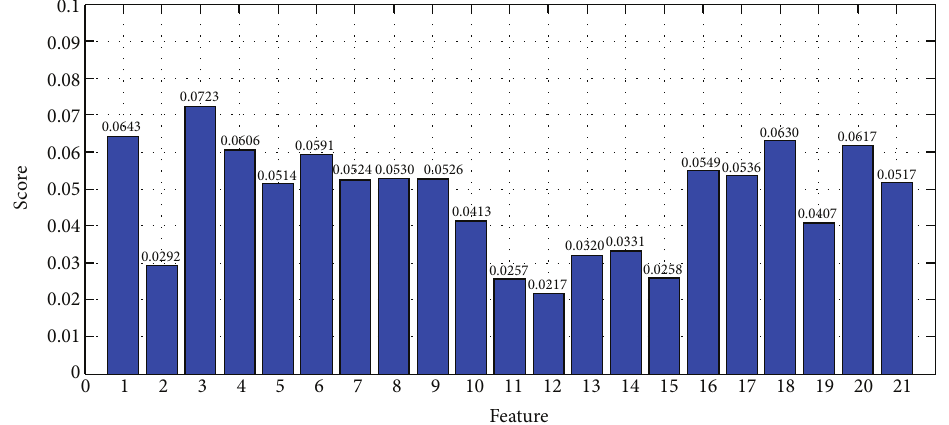
Figure 6: Total score for every